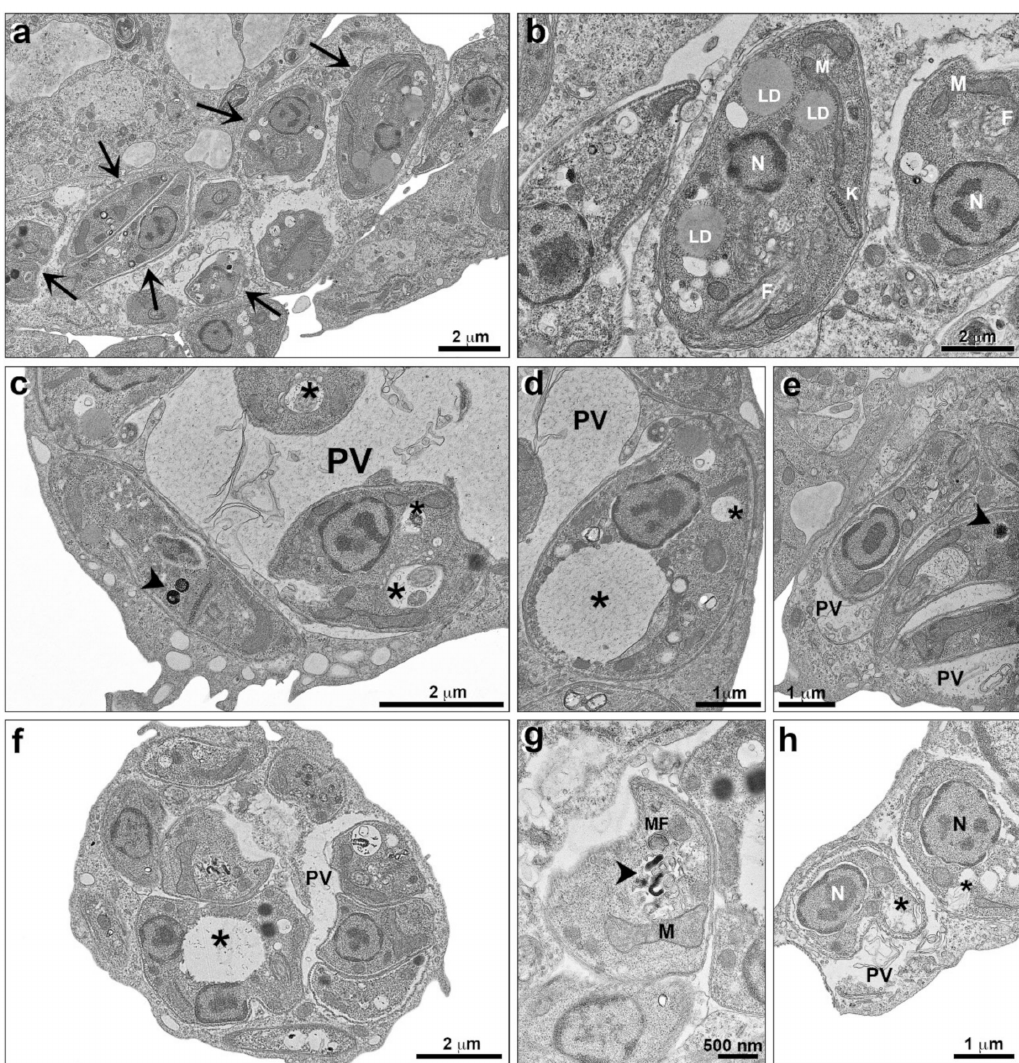
Figure 9. Ultrastructural analysis of L. amazonensis intracellular amastigotes treated with TPCK ob- served by TEM. ( a , b ) Control amastigotes (untreated) are seen inside parasitophorous vacuoles (arrows) with a homogeneous cytoplasm and regular organelle aspects; ( c – e ) treatment with TPCK at 15 µ M, a parasitophorous vacuole extension inside macrophages is noted. Large amastigote cytoplasmatic vac- uoles are seen ( c , d —asterisks), some containing a membranous profile ( e —arrowhead) or electron dense material ( c —arrowhead); ( f – h ) treatment with TPCK at 30 µ M, electron-dense material ( g —arrowhead) and membranous profile inside large vacuoles ( h —asterisks) are observed. N, nucleus; LD, lipid droplets; M, mitochondria; K, kinetoplast; PV, parasitophorous vacuole; MF, myelinic